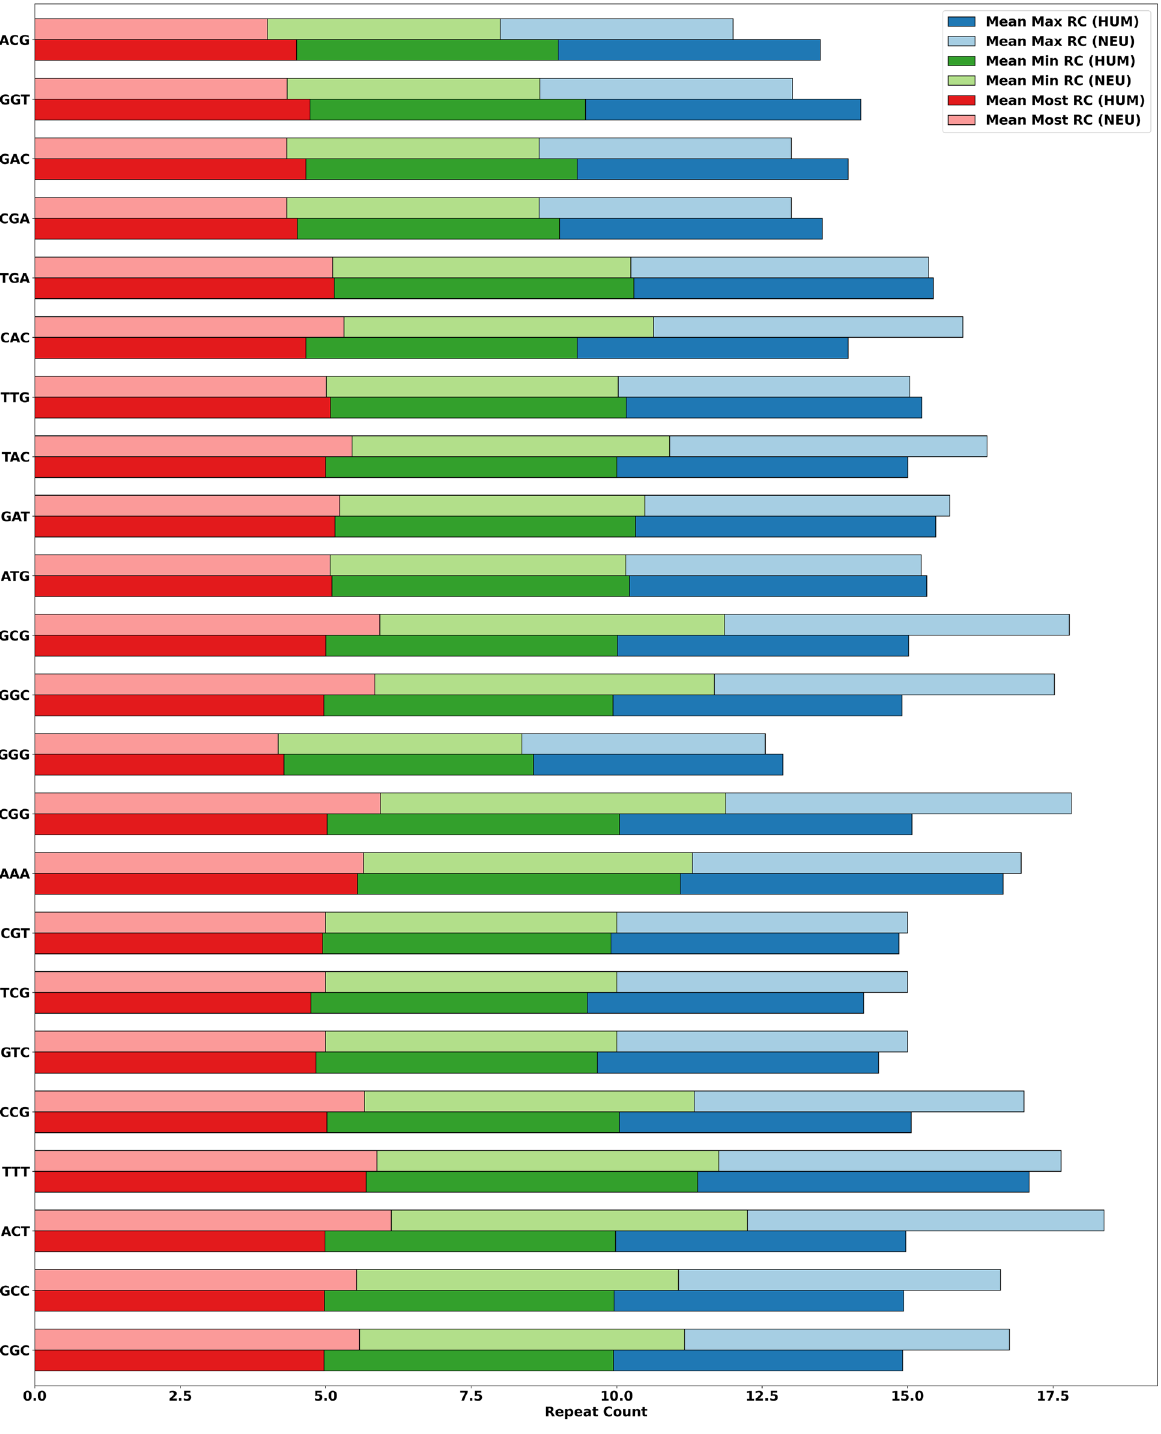
Figure 6. Mean distribution of max-, min-, and most- RC of the least significant RUs (LSRUs) between the two datasets, where LSRU CGC has the highest adjusted p value, followed by LSRU GCC, and so